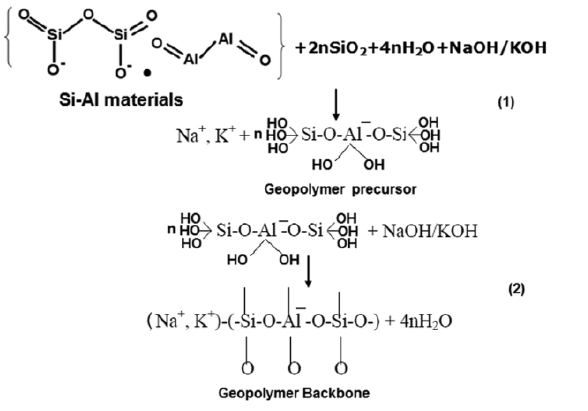
Figure 5: Schematic diagram of the formation of geopolymer materi- als